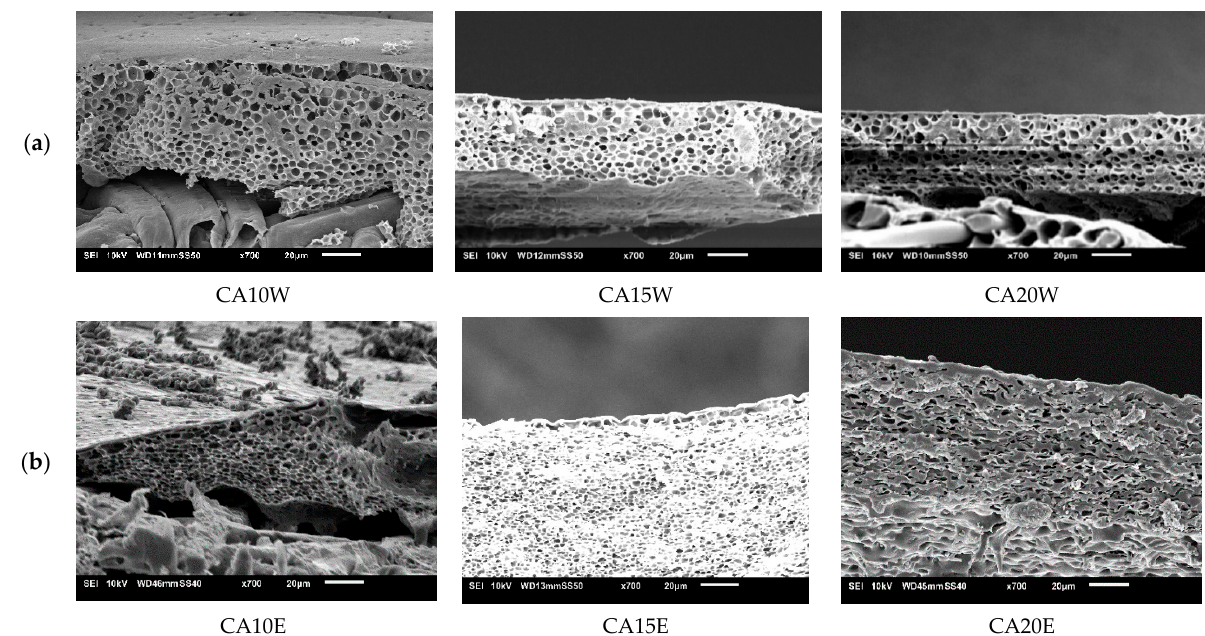
Figure 5. Influence of CA concentration on the scanning electron microscopy (SEM)-cross-section morphology of CA membranes cast from using ( a ) water as non-solvent and ( b ) ethanol as non-solvent.